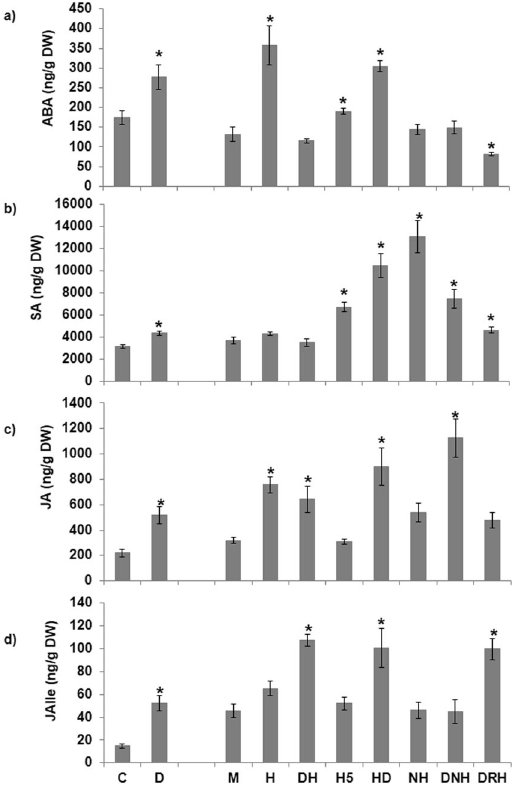
Figure 1. Modulation in phytohormones levels in leaves of Arabidopsis thaliana exposed to individual and combined stresses. Leaf samples were harvested at 8 hours post pathogen inoculation/combined stress treatment (hpt), lyophilized and were used for LC-MS based phytohormone quantification. Plants were subjected to drought (D), host pathogen (H, Pseudomonas syringae pv. tomato DC3000) or H5 (host pathogen treatment for 4.8 days), non-host pathogen (NH),combined drought followed by pathogen (DH) or non-host pathogen (DNH), combined pathogen followed by drought stress (HD), combined drought or pathogen infection during drought recovery (DRH) along with their respective controls (D over absolute or H, H5, NH, DH, HD, DNH and DRH over mock control). All leaves were used to quantify hormone concentrations. Absolute levels of ABA ( a ), SA ( b ), JA ( c ) and JA-Ile ( d ) are presented in terms of ng/g dry weight of the samples. Each data point represents the mean of at least three independent replicates and error bars denote standard error of mean. Significant difference in hormone levels in individual drought stressed samples was assessed over absolute control. Significant difference in hormone levels in individual H, H5, NH or combined HD, DNH and DRH treatments was assessed over mock control. Significant difference between different treatments and controls was analyzed by student’s t -test. Asterix represent significant difference between treatment and control at p < 0.05. Comparison among individual and combined stresses is presented in terms of fold change over their respective controls in Supplementary Figs S4–S6. Raw values for phytohormone concentrations at 2, 8 and 24 hpt, number of replicates and calculated standard error of mean over respective controls are presented in Supplementary File